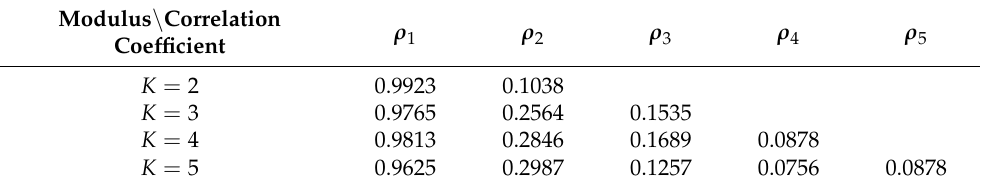
Table 1. Correlation coefficients between each modal component and the original signal under different K